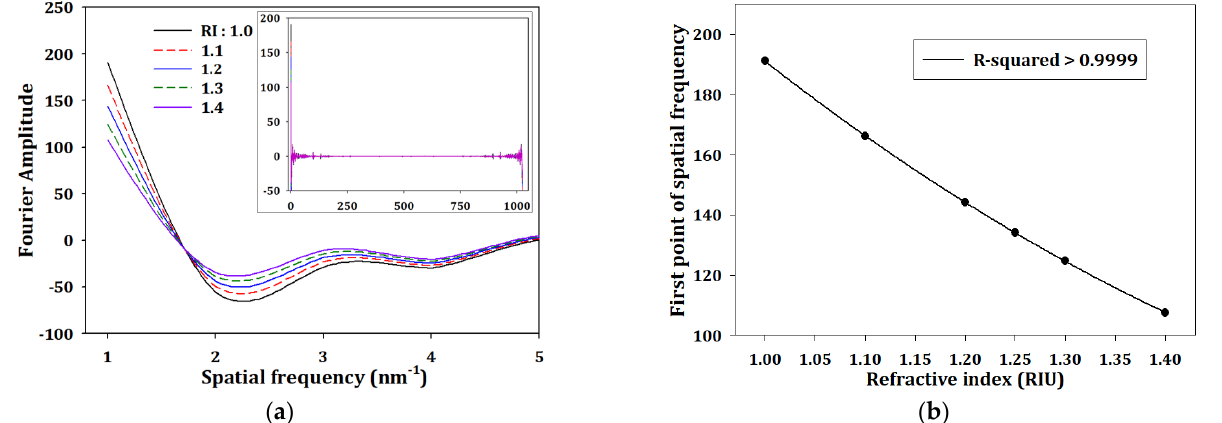
Figure 7. ( a ) The calculation of Fourier amplitude and ( b ) the trends in first point of spatial frequency from Figure 4a.